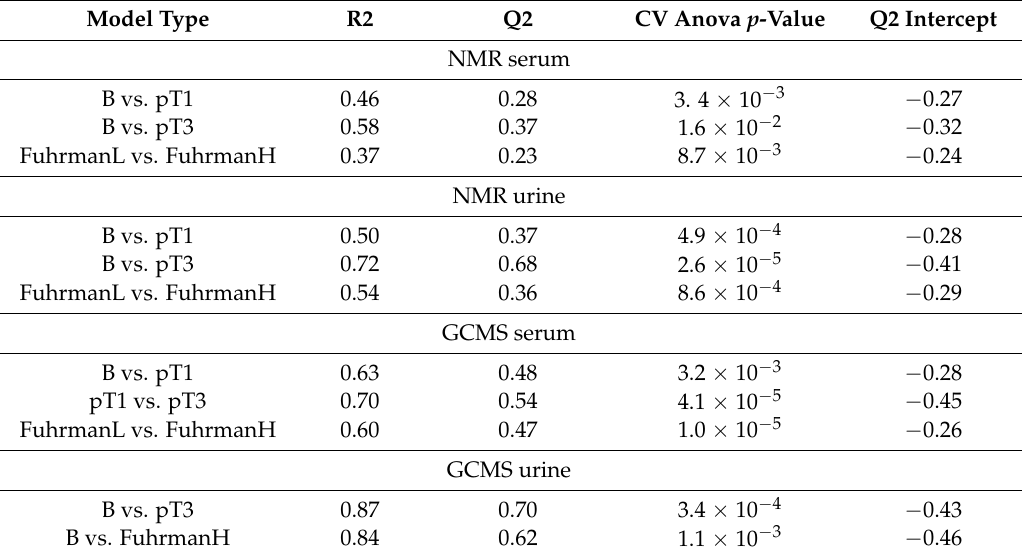
Table 2. Statistical metrics of individually analyzed and Integrated NMR and GCMS orthogonal partial least squares discriminant analysis (OPLS-DA) models (B =